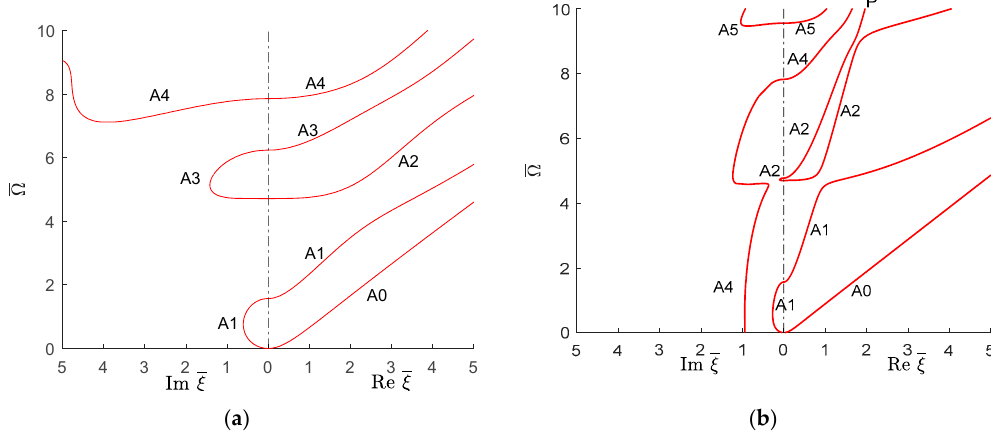
Figure 16. Real (propagating) and imaginary (evanescent) wavenumber solution of antisymmetric Lamb wave type GWs for ( a ) isotropic aluminum alloy; ( b ) unidirectional CFRP composite.